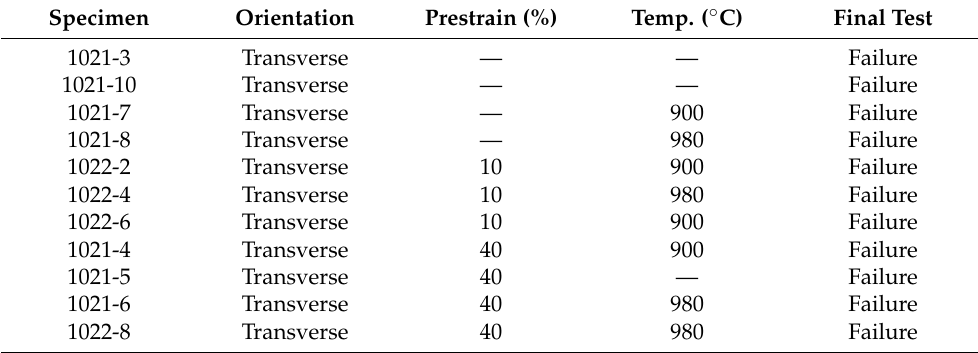
Table 3. Eleven test specimens evaluated for heat treatment response. Several tensile specimens were tested to evaluate the testing methodology and increase the confidence of the